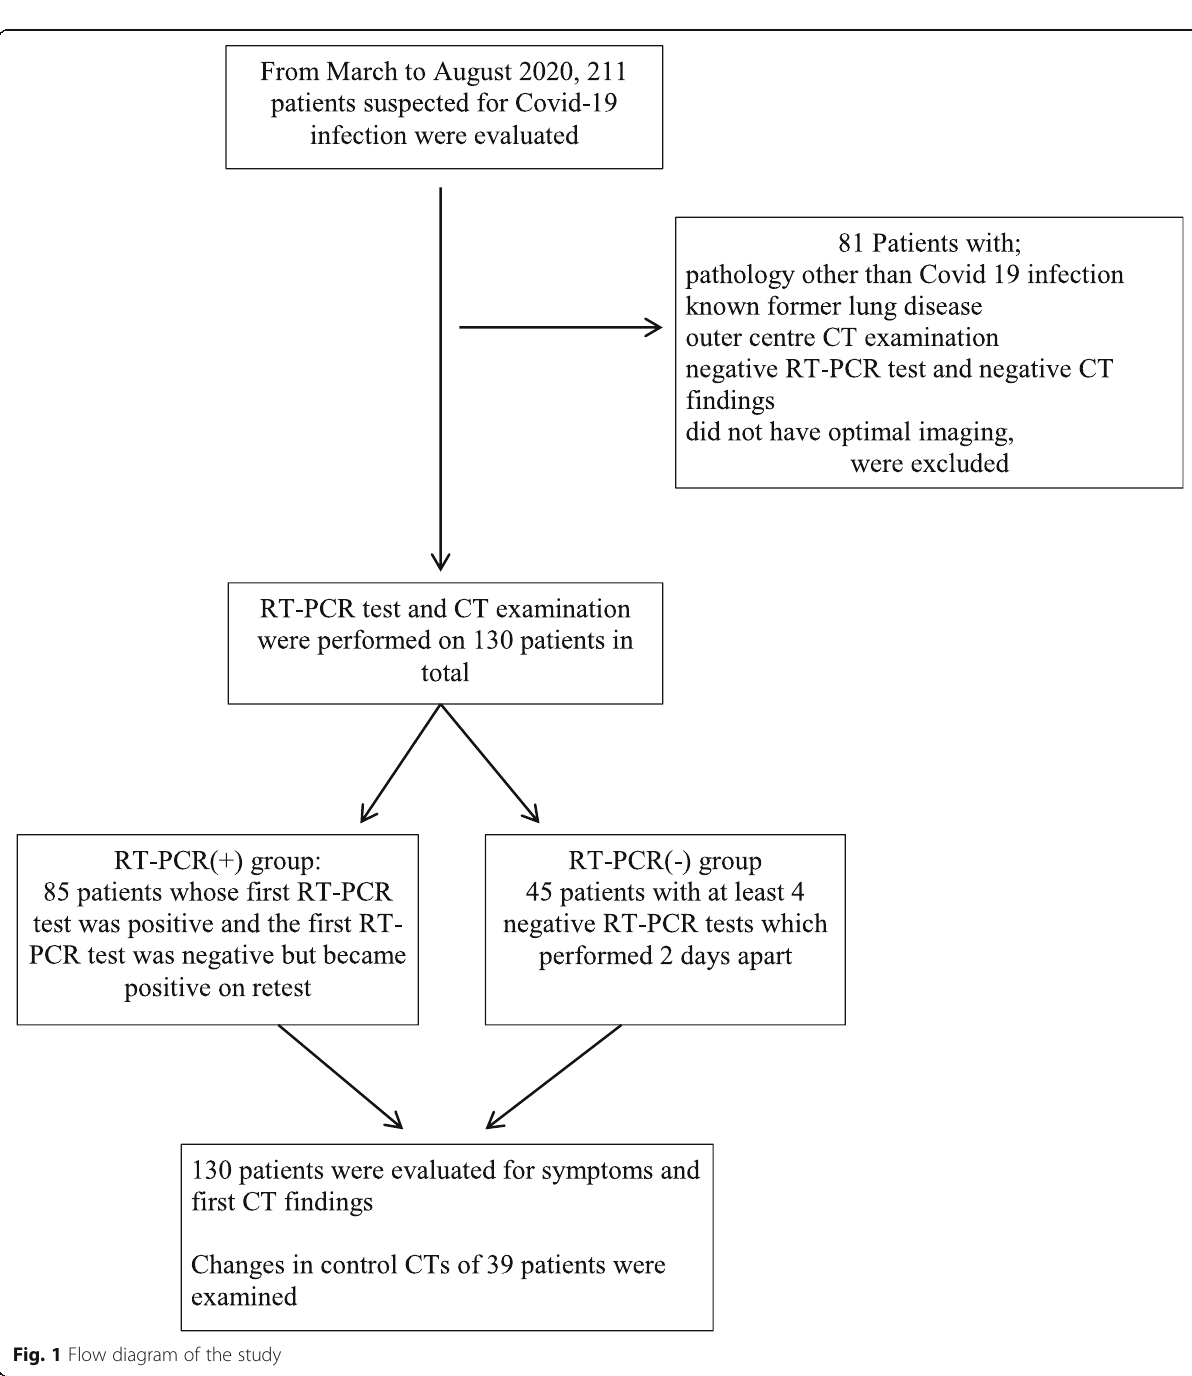
peripheral (outer one-third of the lung), central (inner two-thirds of the lung), or peripheral + central localization. Images were also evaluated in terms of bilateral distribution and affected lung lobes. In pa- tients who underwent follow-up CT imaging, changes in comparison to the first CT image were classified as increased, unchanged, regressed, or normal.